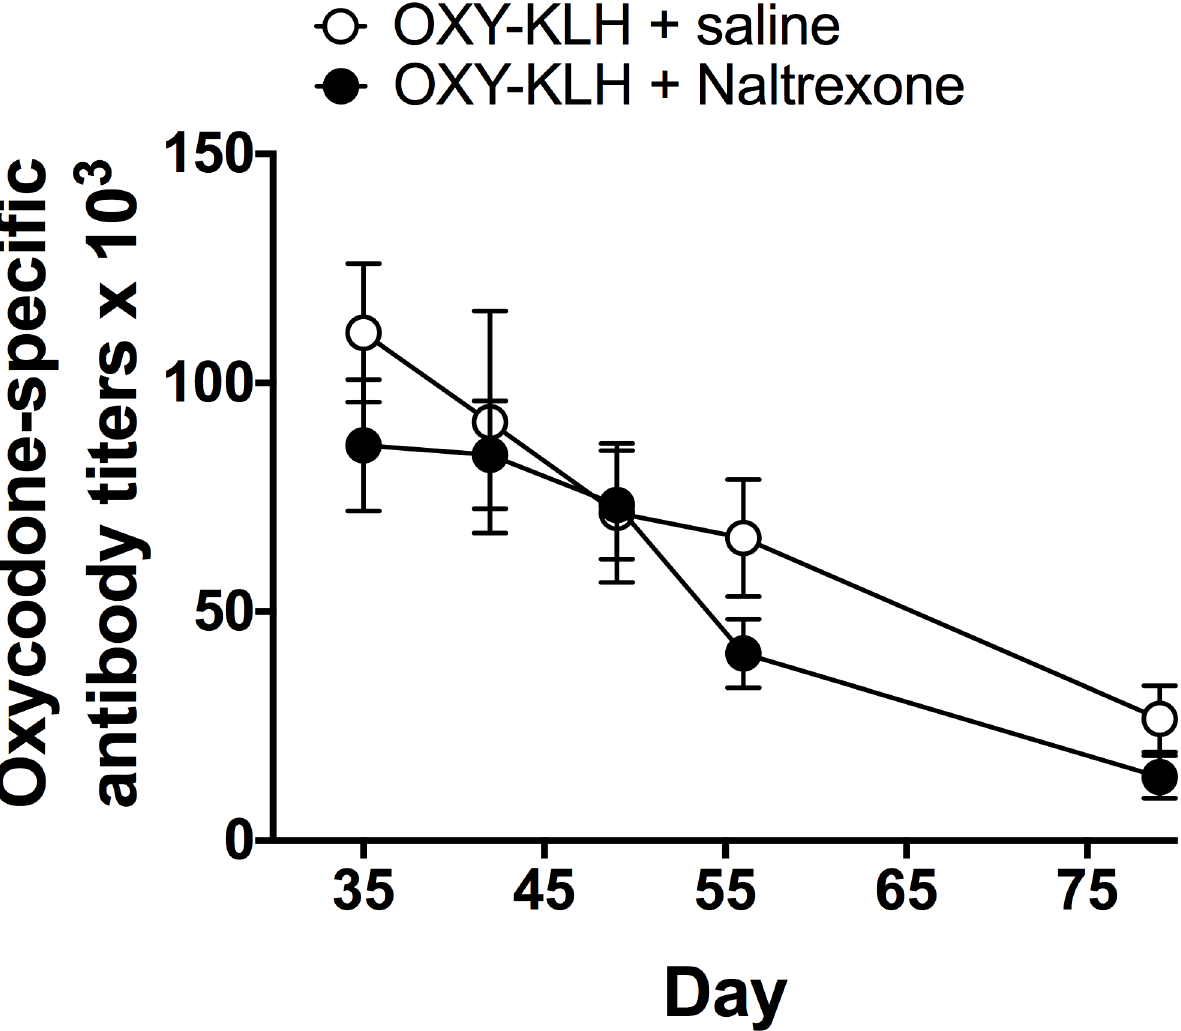
Fig 4. Concurrent administration of extended-release naltrexone does not interfere with oxycodone vaccine immunogenicity. Mice received50 mg/kg naltrexonei.m. on day -1 and then vaccinatedwith OXY-KLH on days 0, 14 and 28. Serum oxycodone-specific antibody titers did not differ betweengroups at any time after completionof vaccination (p = 0.21). Mean ± SEM, n = 4–7/group.